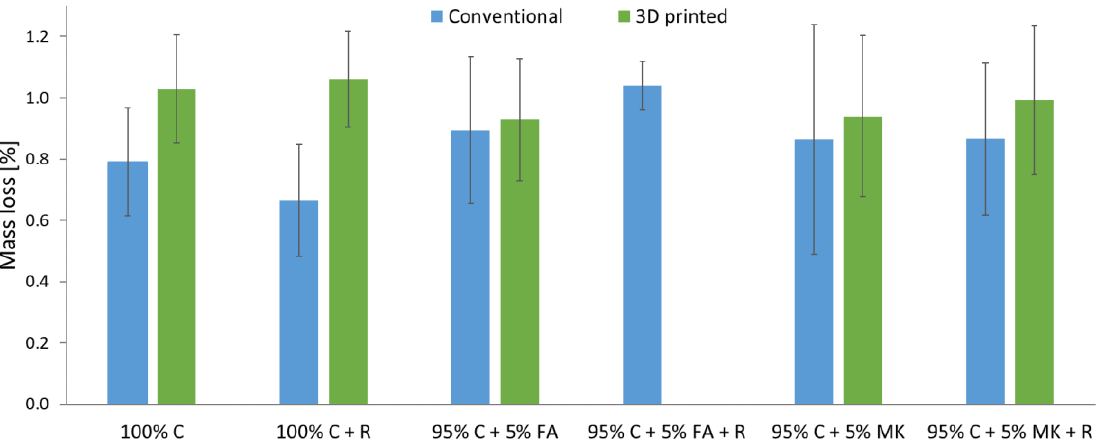
Figure 6. Mass loss after freeze–thaw cycles for concrete and concrete–geopolymer hybrids produced by casting and 3D printing.